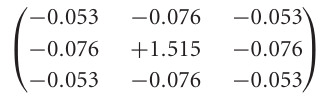
retinotopic motion information is shunted before it reaches the FD1 cell (box “shunting inhibition”). The shunting is accomplished by a division by the vCH cell signal. The transmission is characterized by a half-wave rectification and a sigmoidal transmission function. Before the spatial signals are integrated by the model FD1 (box “FD1”), the excitatory and the inhibitory input channels are individually transmitted via a sigmoidal transmission function and weighted according to the spatial sensitivity of the respective FD1 cell (inset “weighting function right FD1”). The retinotopic signals are spatially integrated by means of an electrical equivalent circuit of a one-compartment passive membrane patch. One channel controls the inhibitory, the other the excitatory conductances of the integrating element. The integrated signals of all elements are temporally low-pass filtered to account for time constants of the cell. Additionally, the model FD1 is characterized by a threshold, because as a spiking element, it cannot convey negative signals. Inset box at bottom right: explanation of symbols referring to the computations in the